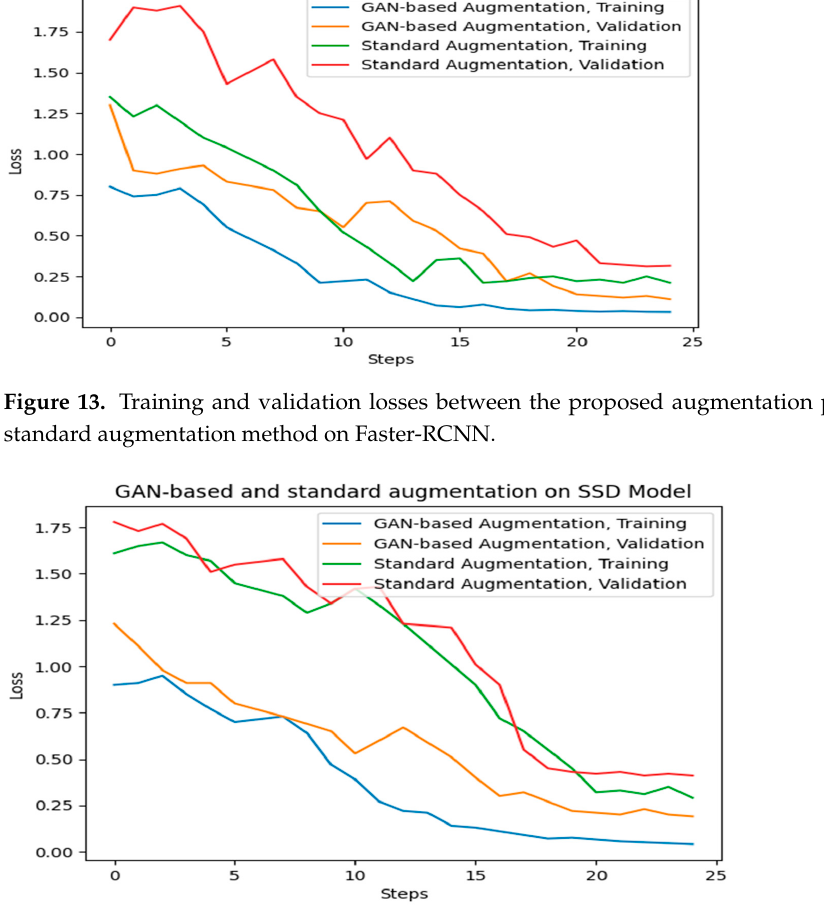
Figure 15. K-fold validation.